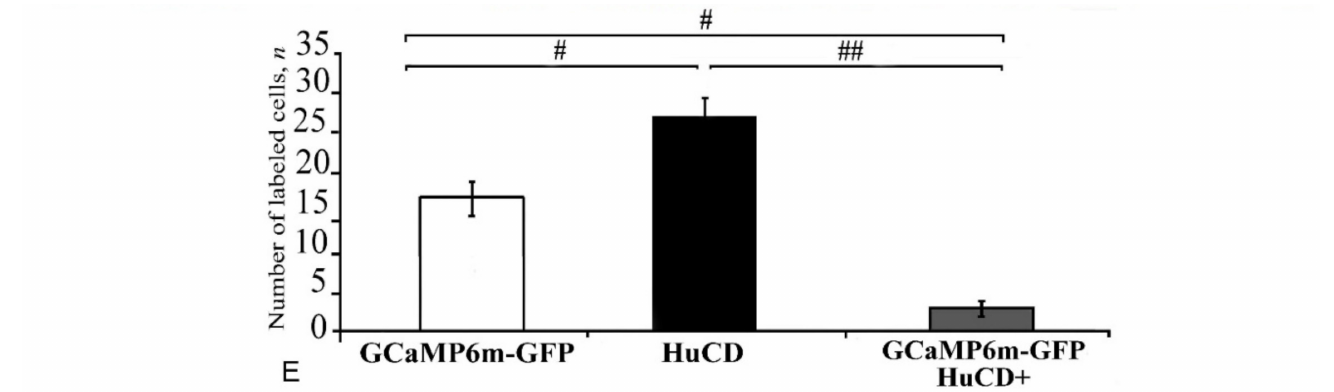
Figure 7. Z-stacks showing DAPI staining, localization of green fluorescent protein GFP and HuCD, and their colocalization in the dorsal thalamus of juvenile chum salmon, O. keta , at 90 days after a single injection of the rAAV into the cerebellar body. ( A ) DAPI staining with a pictogram showing the dorsal thalamic region (in a red box), rounded nuclei (white arrows), elongated nuclei (red arrows); PVZ, periventricular zone; SVZ, subventricular zone; PZ, parenchymal zone. ( B ) Expression of green fluorescent protein GFP in dorsal thalamic cells (yellow dotted square). ( B1 ) The enlarged fragment outlined by a dotted square in B1; GFP+ neurons (green arrowheads); GFP+ granules (green arrowheads). ( C ) HuCD immunofluorescence in dorsal neurons (red arrows) of thalamus (red dotted inset). ( D ) Optical overlay of three DAPI/GFP/HuCD staining channels showing areas of GFP/HuCD colocalization in neurons (yellow dotted box). ( D1 ) The enlarged fragment outlined by a yellow dotted box in D; neurons co-expressing GFP and HuCD (yellow arrows), DAPI-stained nuclei (white arrows), GFP+ neurons (green arrows), and GFP+ granules (green arrowheads). Scanning confocal microscopy. Scale bar: ( A , B , C , D ) 50 µ m; ( B1 , D1 ) 20 µ m. ( E ) One-way ANOVA showing the relative distribution of GFP and HuCD immunolabeled cells (M ± SD) in the dorsal thalamus of juvenile chum salmon, O. keta . Significant intergroup differences were found in GCaMP6m-GFP and HuCD, GCaMP6m-GFP and GCaMP6m-GFP/HuCD+ (# <0.05) ( n = 5 in each group), and HuCD and GCaMP6m-GFP/HuCD cells (## <0.01) ( n = 5 in each